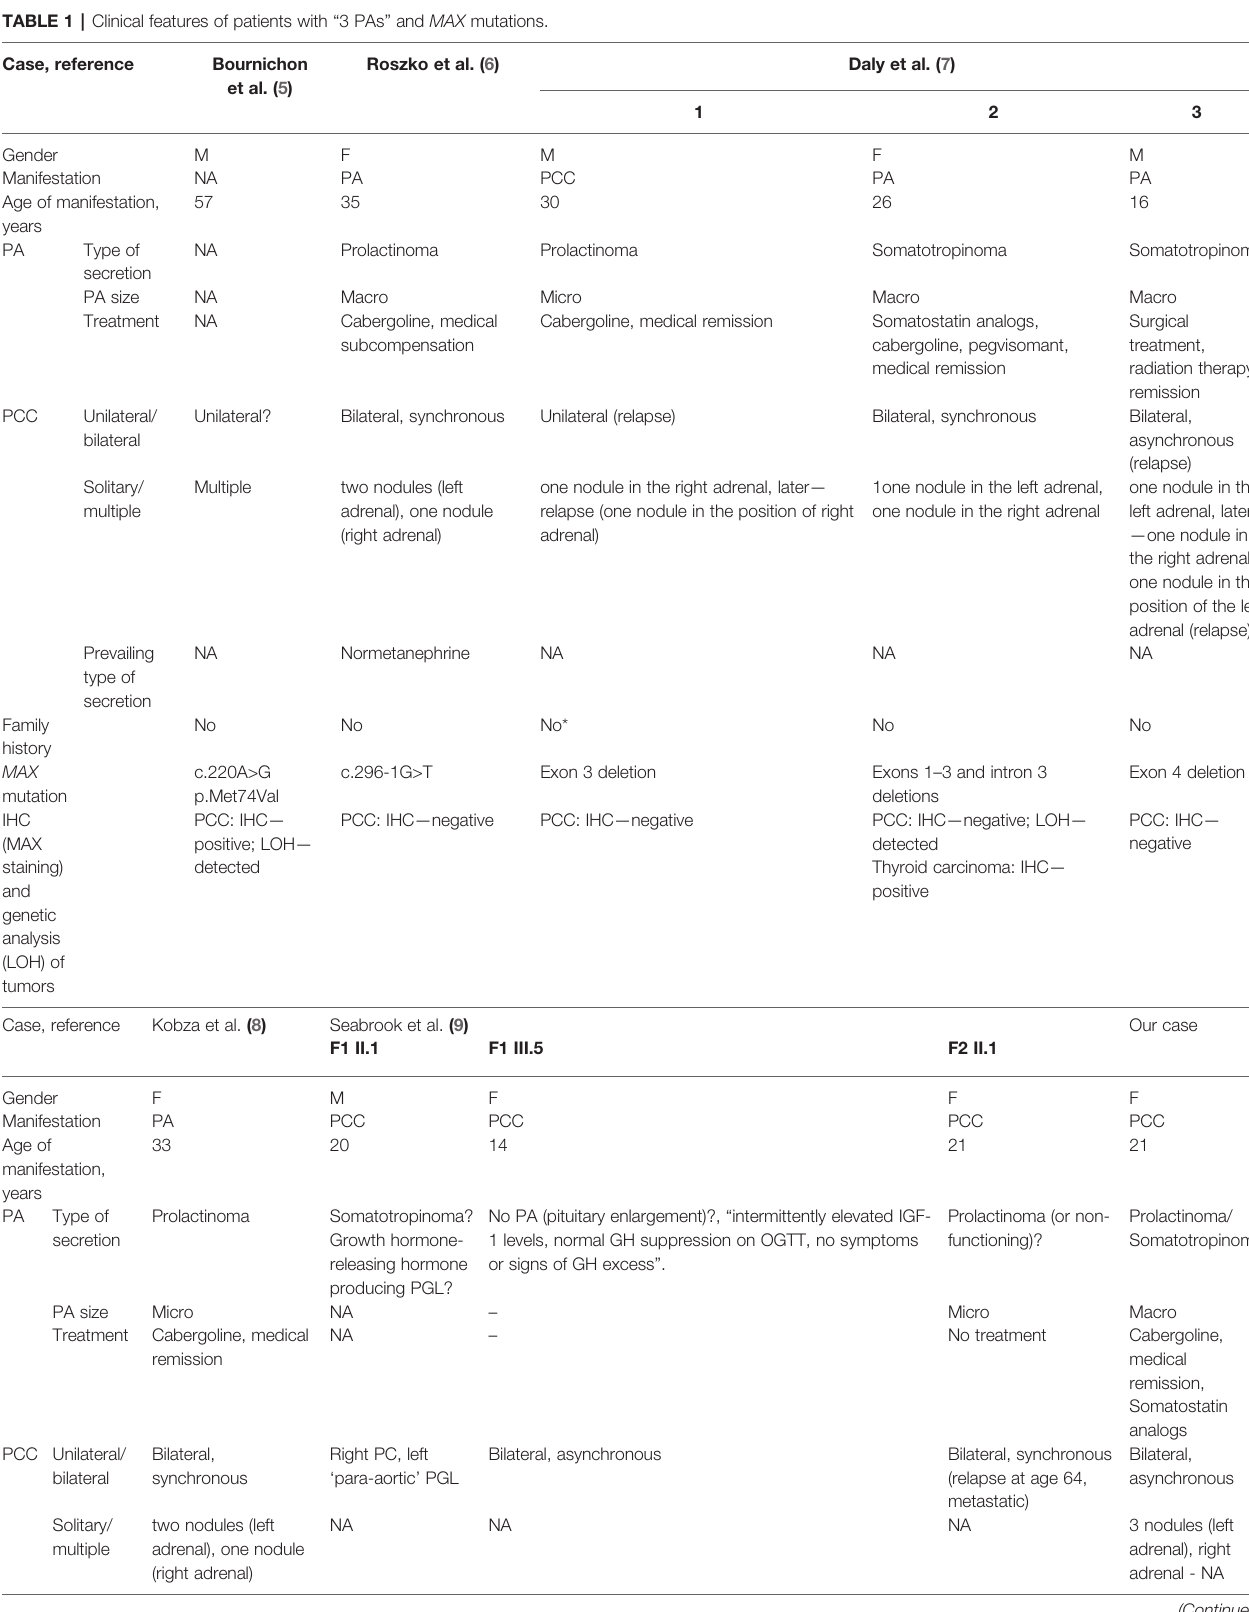
TABLE 1 | Clinical features of patients with “ 3 PAs ” and MAX